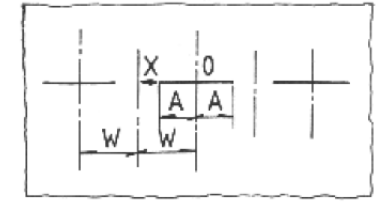
Figura 4: Serie periodica di fessure passanti in una lastra infinita (tratta da[3]).